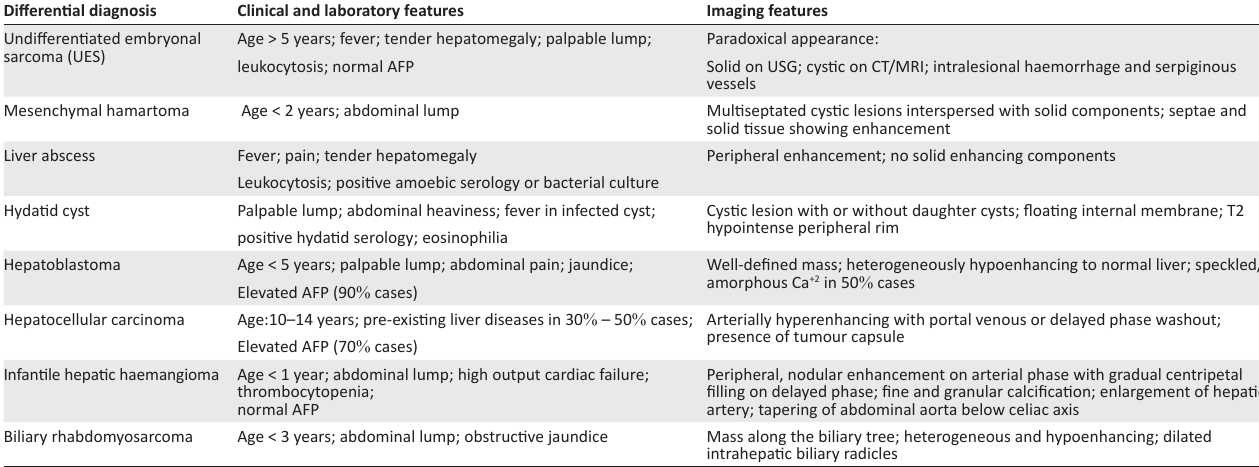
TABLE 1: Differential diagnoses of Undifferentiated Embryonal Sarcoma of liver. Differential diagnosis Clinical and laboratory features